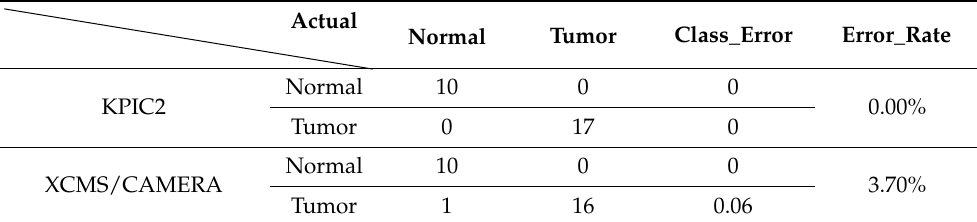
Table 3. Classification results of the LCC dataset on the test